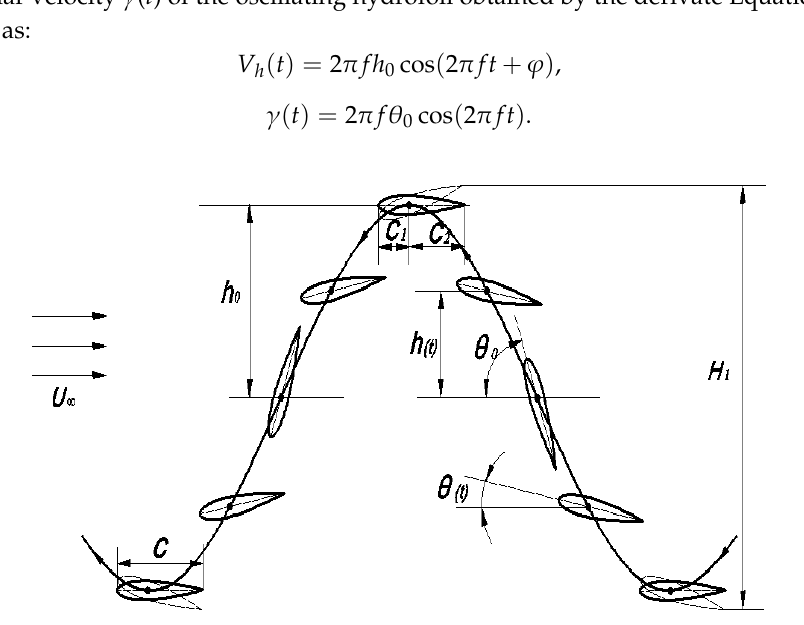
Figure 1. Kinetic model of the oscillating hydrofoil.